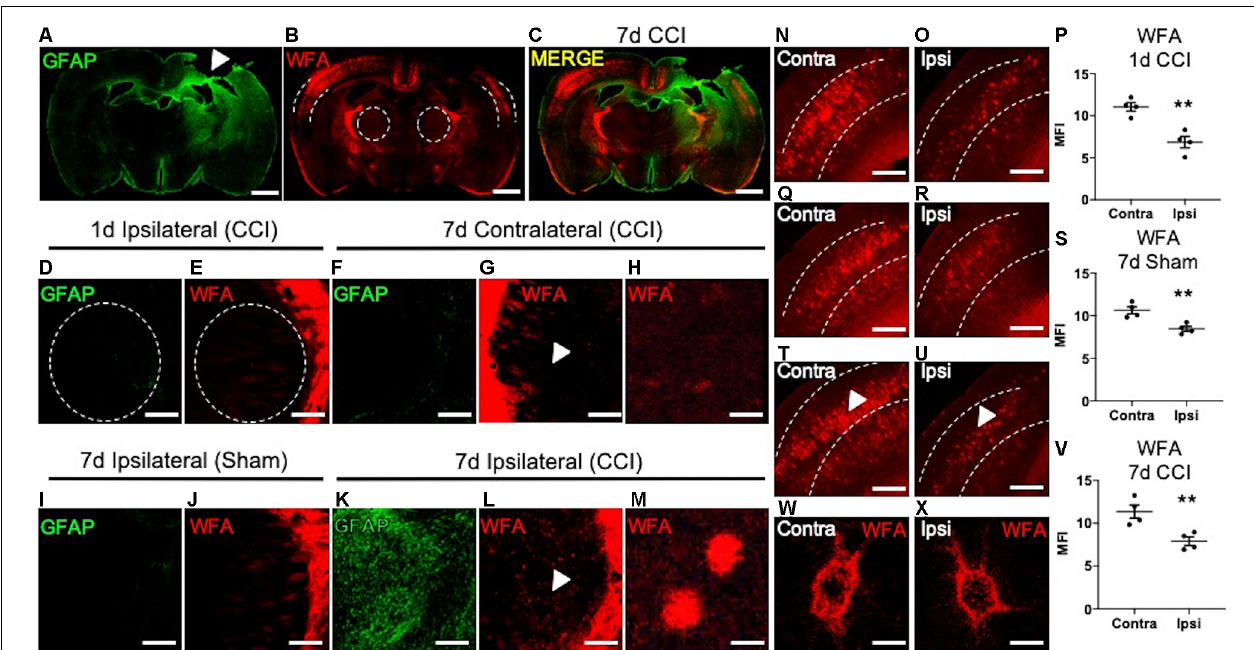
FIGURE 1 | Loss of cortical PNNs and appearance of thalamic WFA + puncta post-CCI in mice. A representative tile image of a coronal section (30 µ m) from a C57BL/6 mouse brain at 7 days following an open-skull CCI procedure. Robust GFAP immunostaining is observed at the cortical injury site ( white arrow, A) , which extends ventrally into the ipsilateral thalamus, but not the contralateral thalamus. Immunofluorescence detection of WFA, a lectin that associates with the CS/DS-GAGs of PNNs, was markedly decreased in the ipsilateral cortex ( dashed lines ) adjacent to the impact site (B) , and merged image (C) . At 1-day post-CCI, normal expression of GFAP (D) and WFA (E) were observed in the ipsilateral thalamus ( dashed lines ). Normal expression of GFAP (F) and WFA (G) were observed in the contralateral thalamus at 7 days post-CCI, white arrow in (G) demarcates magnified image of normal thalamic WFA expression (H) . The ipsilateral thalamus of 7- day post-sham control mice showed normal expression of GFAP (I) and WFA (J) . At 7 days post-CCI, the ipsilateral thalamus showed robust GFAP (K) and WFA immunostaining (L) . White arrows in (L) demarcate the appearance of WFA + puncta in the ipsilateral thalamus at 7 days post-CCI (M) . Normal levels of WFA + PNNs are observed in the contralateral cortex at 1-day post-CCI (N) , 7 days post-sham (Q) , and 7 days post-CCI (T) , a decrease in WFA + PNNs were observed in the ipsilateral cortex at 1-day post-CCI (O) , 7 days post-sham (R) , and 7 days post-CCI (U) , and quantified in (P,S) , and (V) . PNN morphology of WFA immunolabeled PNN structures were similar between the contralateral (W) and the ipsilateral (X) cortices at 7 days post-CCI. (P,S,V) Student’s t -test, N = 4, ** P < 0.01 . Scale bars = 1,000 µ m (A–C) , 200 µ m (D–G,I–L,N–U) and 10 µ m (H,M,W,X)